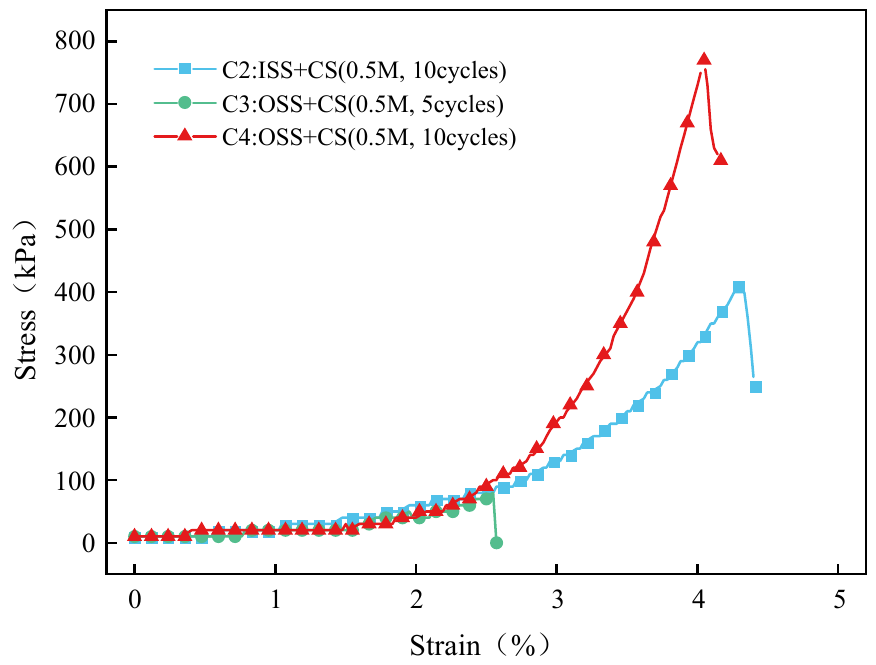
Figure 12. Stress-strain curve of the treated Figure 12. Stress ‒ strain curve of the treated samples.